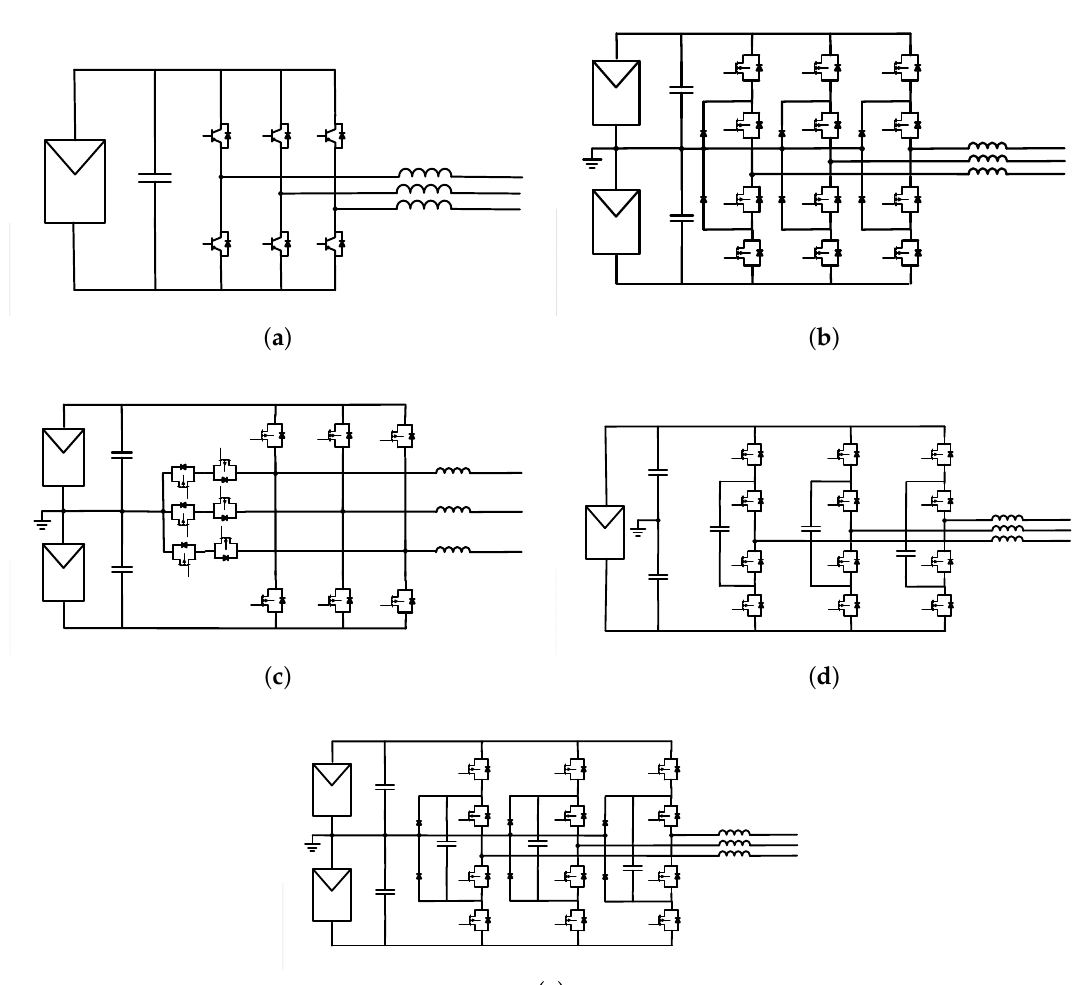
Figure 2. Representative power inverter topologies for utility-scale photovoltaic plants (USPVPs) applications: ( a ) two-level three-phase inverter, ( b ) three-level three-phase NPC I-type inverter, ( c ) three-level three-phase neutral point clampled (NPC) T-type inverter, ( d ) three-level three-phase flying capacitor inverter and ( e ) three-level three-phase NPC I-type modified